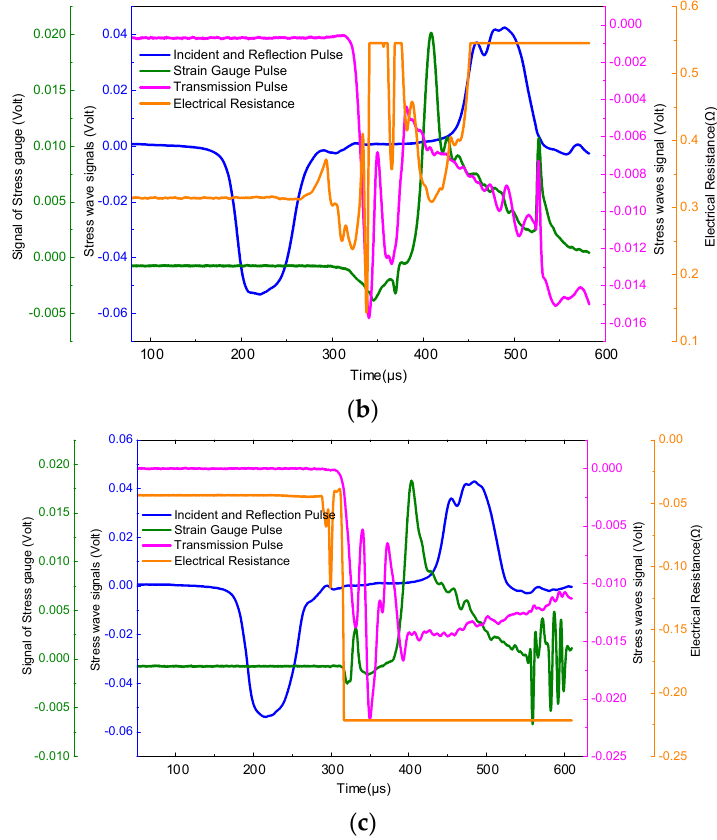
Figure 4. Hopkinson impact test results of unidirectional prepreg composites. ( a ) The driving pressure of the striker is 0.3 MPa. ( b ) The driving pressure of the striker is 0.5 MPa. ( c ) The driving pressure of the striker is 0.7 MPa.